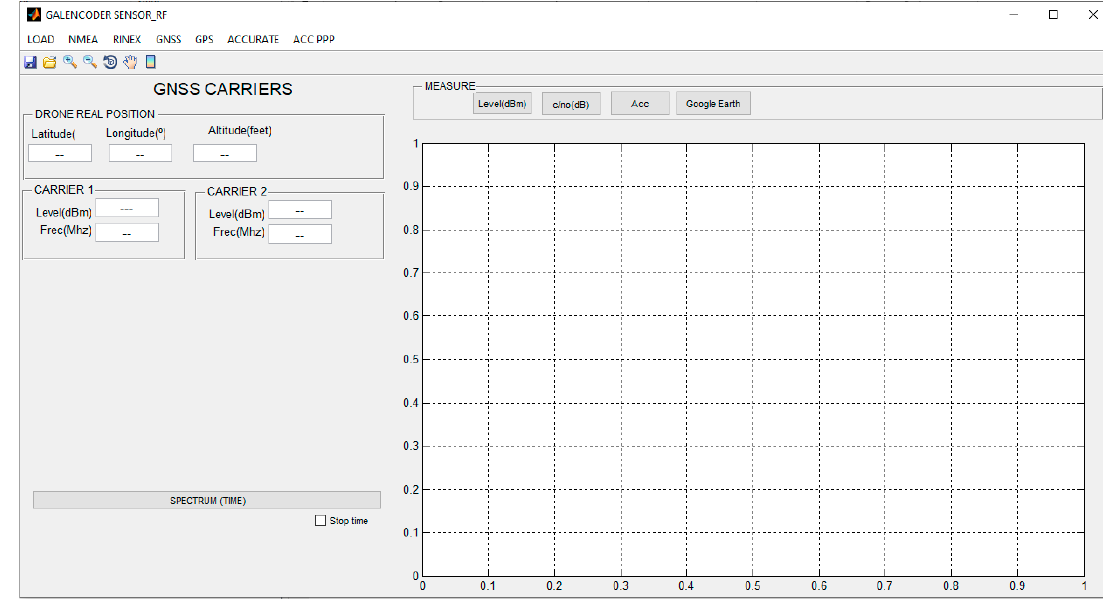
Figure 8. GUI appearance when idle.